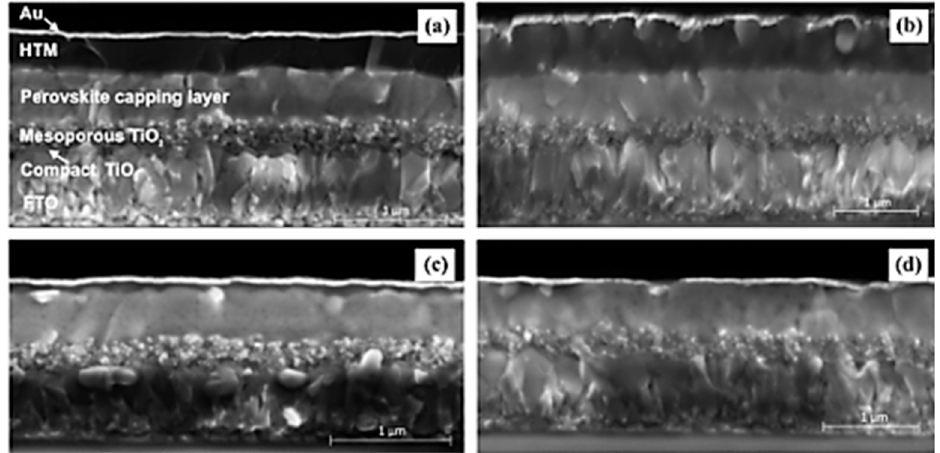
Figure 5. ( a ) SEM cross-section of spiro-OMeTAD-based HTM; ( b ) SEM cross-section of HTM deposited by doctor-blade technique; ( c ) SEM cross-section of HTM deposited by spin-coating technique; ( d ) SEM cross-section of PSC without HTM. Reproduced with permission from Reference [44].